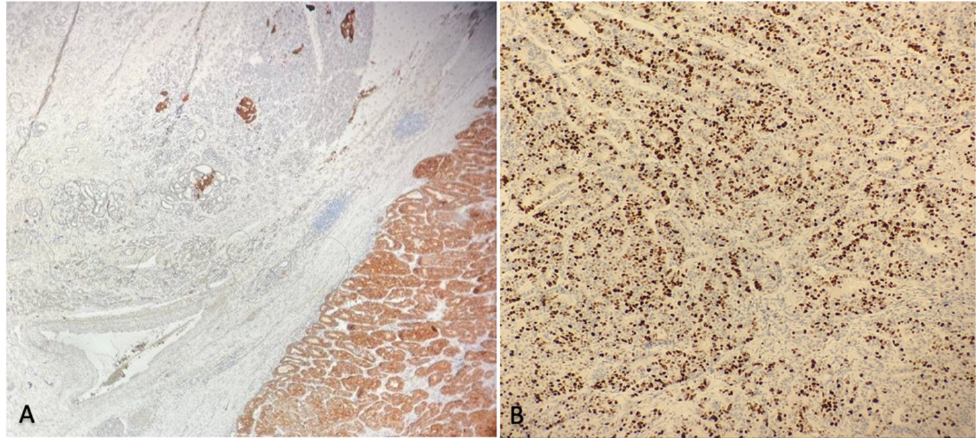
Figure 3. ( A ) Synaptophysin staining showing a diffuse positivity in the neuroendocrine component (on the right) in contrast to the ductal adenocarcinoma component (on the left); ( B ) Ki 67 immunostaining having a proliferation index 70%.